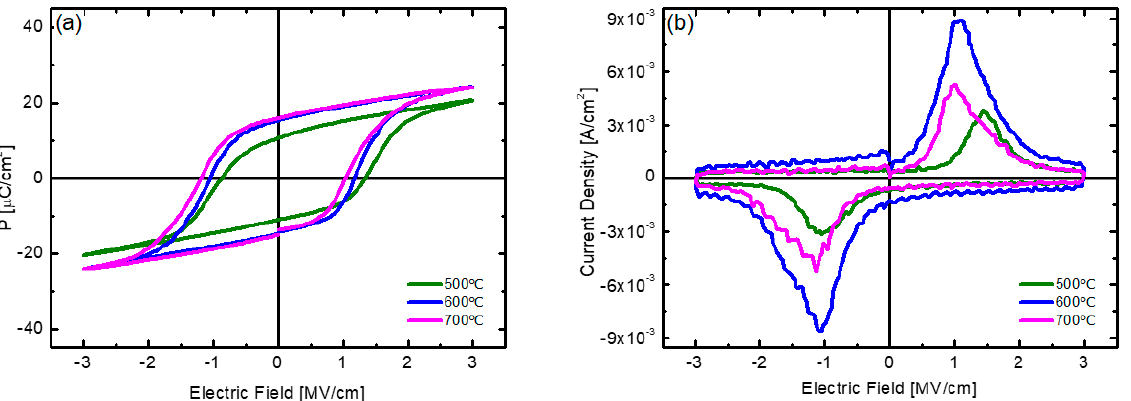
Figure 7. ( a ) P − E hysteresis curve and ( b ) polarization switching current curve with respect to electric field of HZO thin films deposited at substrate temperature of 180 °C with different post-annealing temperatures.